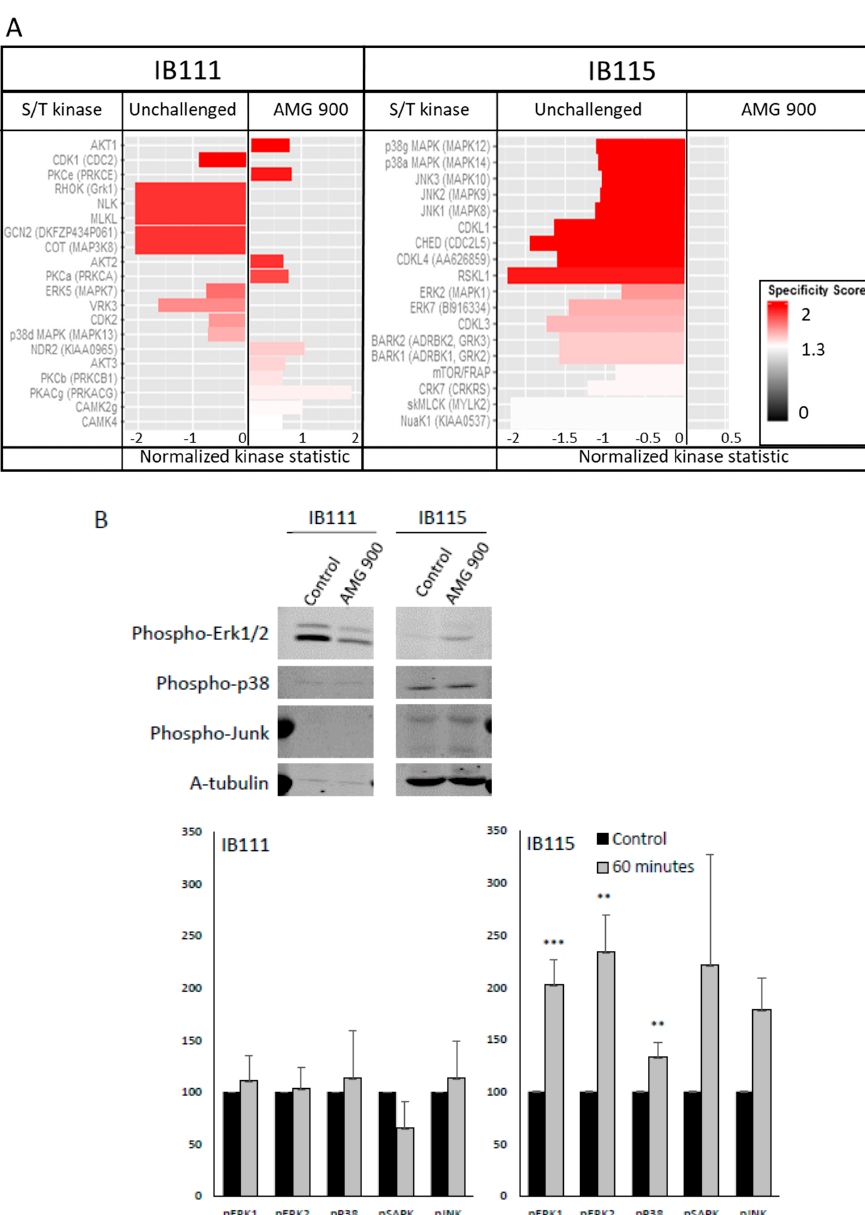
Figure 7. AMG 900 inhibits MAPK activity and modulates phosphorylation in sensitive cell line. ( A ) Variation of serine/threonine kinomic activity in resistant IB111 and sensitive IB115 with AMG 900 treatment. Cells were treated with IC 50 of AMG 900 for one hour before protein extraction and analysis on PamChip. Kinases activities are compared between unchallenged and AMG 900-treated cells. Peptides phosphorylation leads to a serine/threonine kinases list presenting variation between both conditions. Graphic represent IB111 kinase activity in unchallenged (left) and AMG 900 treated-cell (right), intense red color correspond to high specificity score compare to white color. ( B ) Differential phosphorylation of MAPK in IB111 and IB115 cell lines, treated or not with AMG 900. Cells were treated with IC 50 of AMG 900 for one hour before protein extraction and analysis by western-blot. Histograms are mean values of triplicate +/ − SEM. (**: p < 0.01; ***: p < 0.001). More details of western blot, please view at the supplementary materials.